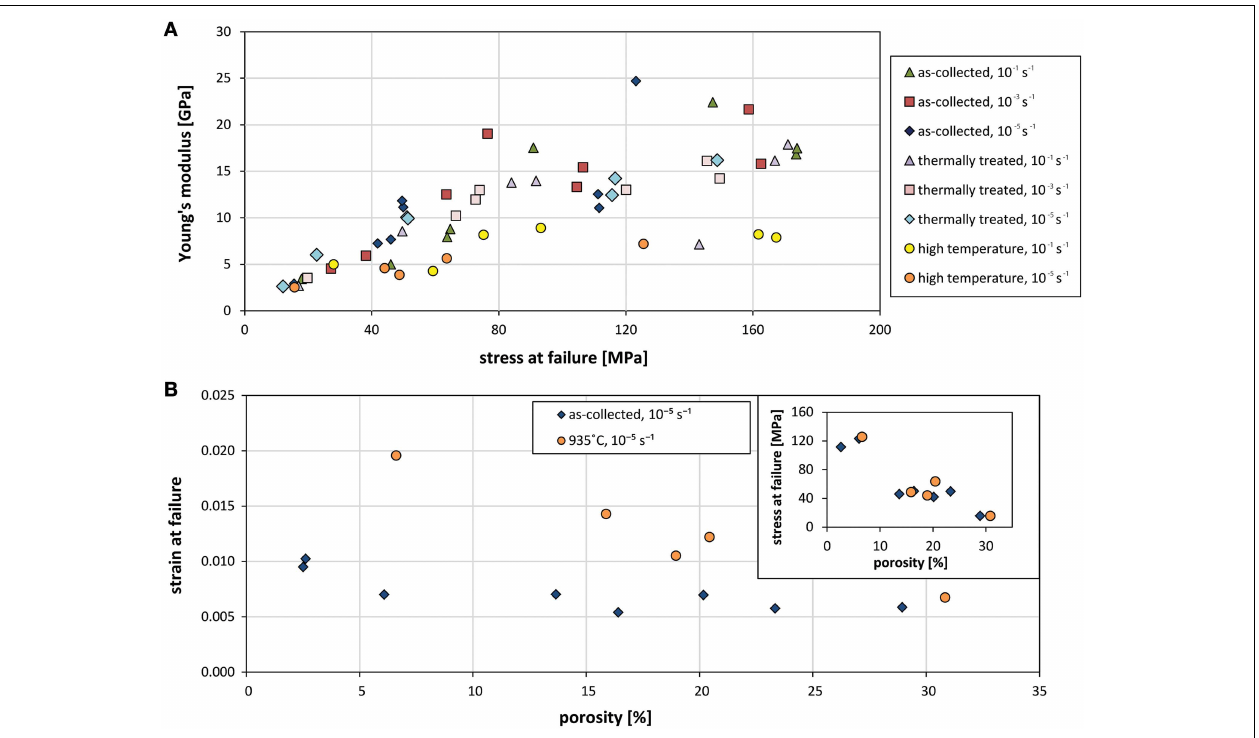
during tests at high temperature display the lowest Young’s Moduli, which correlate with the observation that (B) at high temperature more strain is required to achieve failure than at room temperature; this, despite only a mild strengthening of the material at high temperature